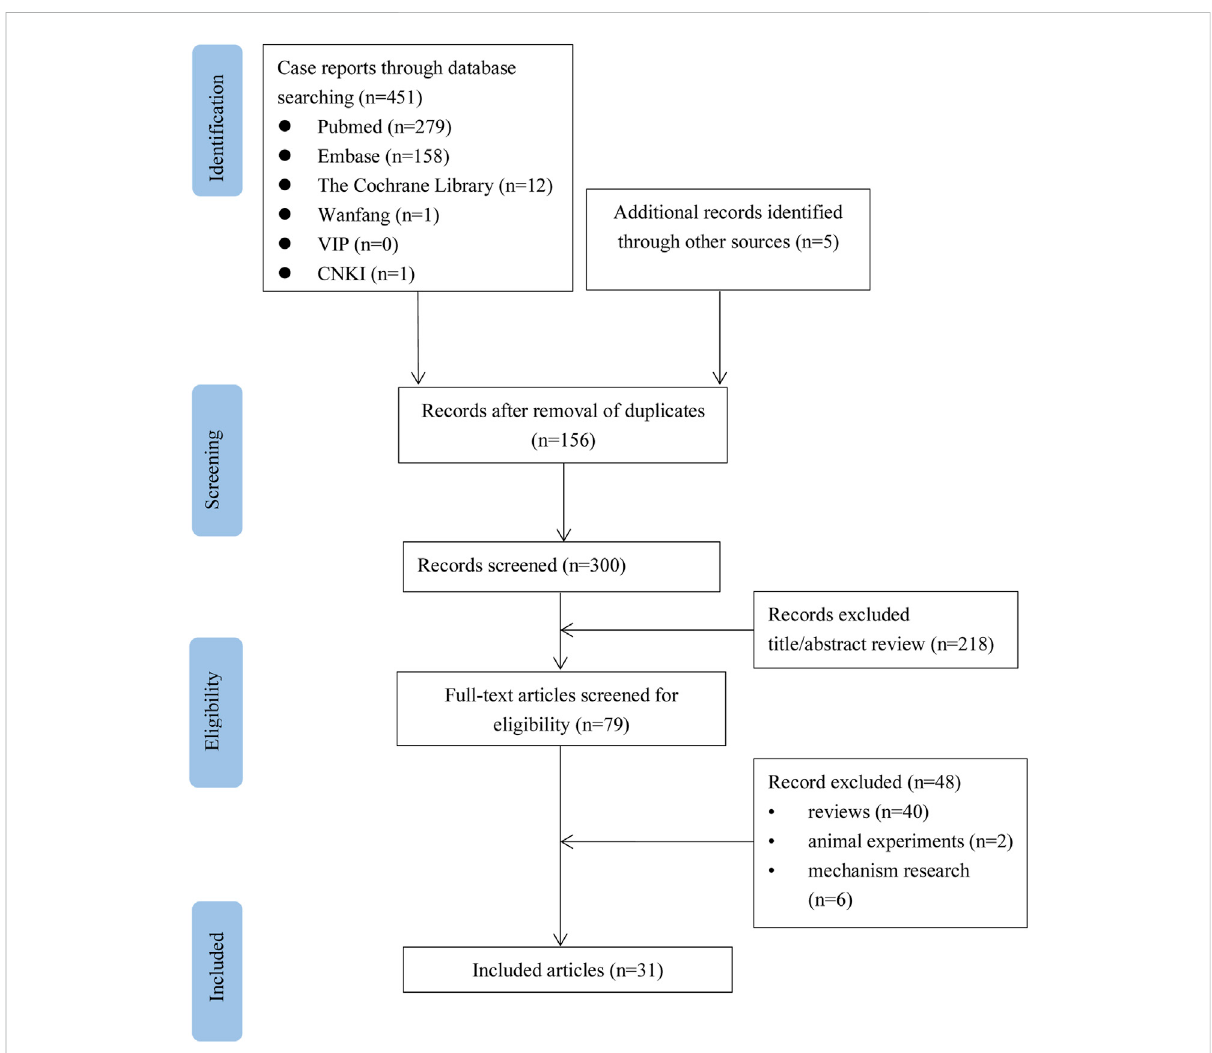
FIGURE 1 Flow chart of the study selection process for reported cases of amoxicillin-induced Kounis syndrome.